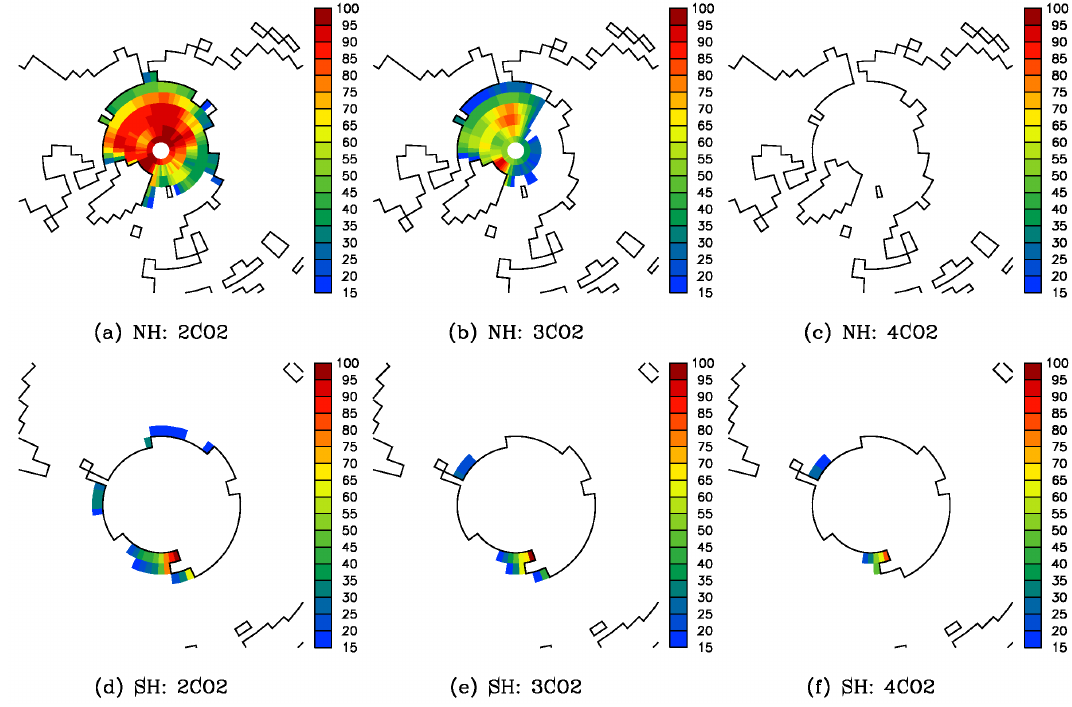
Fig. 21. The average annual-mean sea ice concentration (percent) for years 3901–4000 of each experiment: (a–c) Northern Hemisphere, experiments 2CO2, 3CO2 and 4CO2, respectively, and (d–f) Southern Hemisphere, experiments 2CO2, 3CO2 and 4CO2, respectively. The sea ice concentration is only shown where the value is greater than or equal to